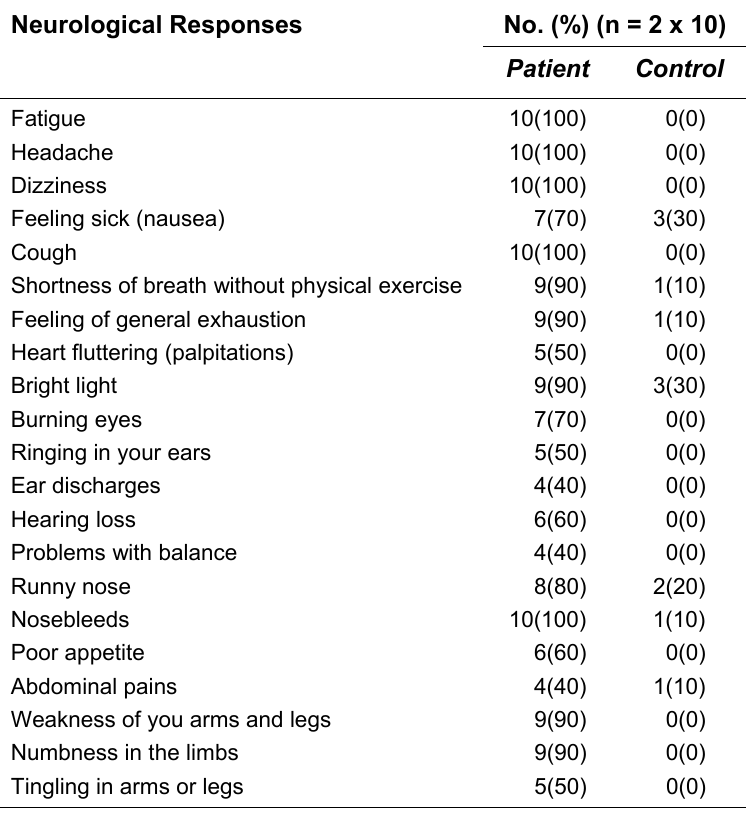
Subjective Neurologic Responses with Parental Cooperation Neurological